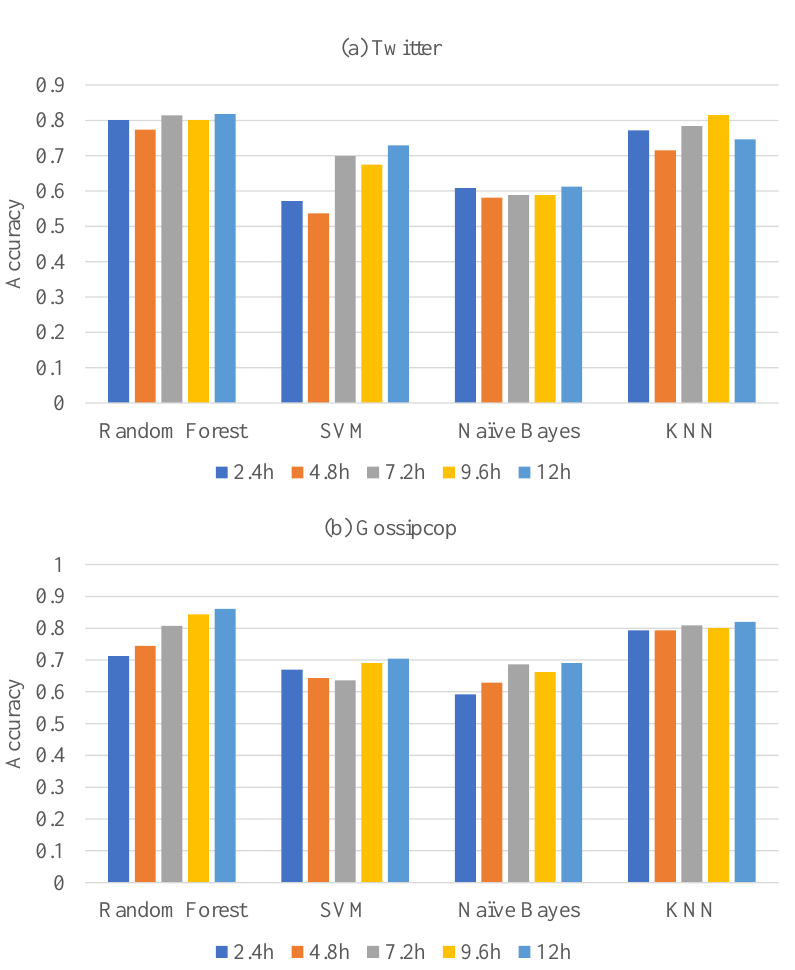
Figure 1. The performance of four baseline algorithms on the Twitter ( a ) and the Gossipcop ( b )